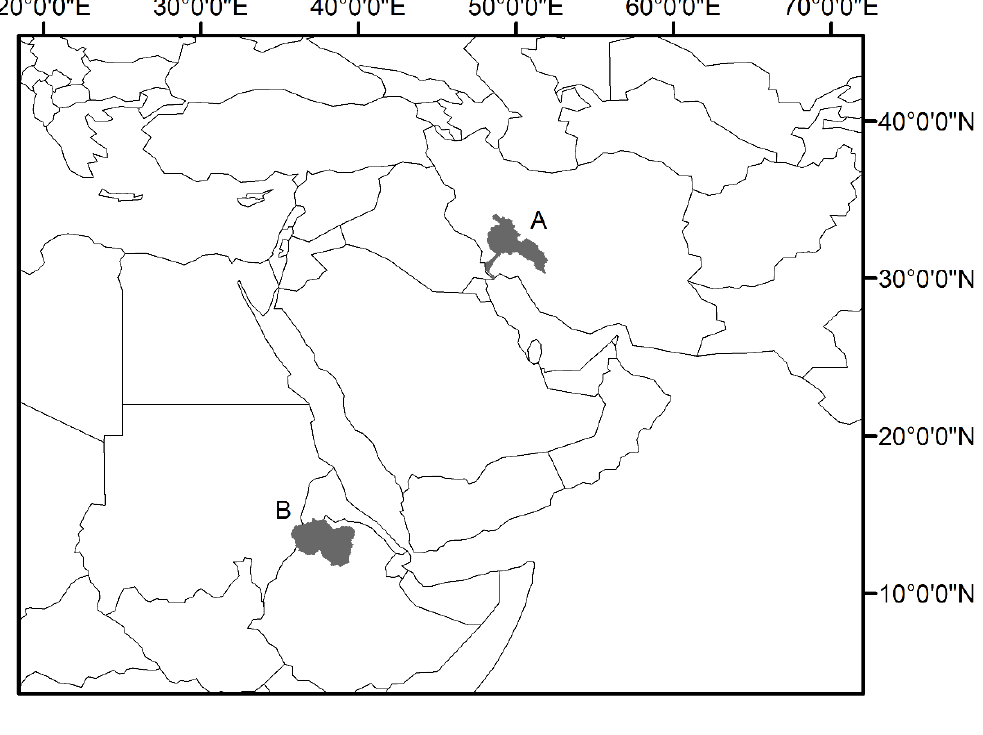
Figure 3. Case study areas. Table 1. Study area description.